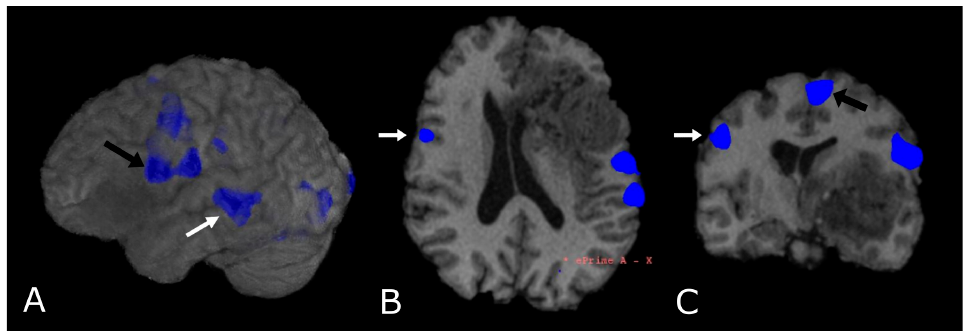
Figure 12. Language task-based fMRI. fMRI correlation maps of cortical activation during language tasks in a patient with frontal-temporal-insular GB. Blue represents areas of increased cortical activation. ( A ) 3D surface rendering with BOLD signal overlay reveals the activation of Broca’s Area, displaced posteriorly by the lesion (black arrow; expressive speech) and in the superior temporal gyrus (white arrow, Wernike’s Area, receptive speech); ( B ) and ( C ) Axial and coronal deskulled T1w-BRAVO with BOLD signal overlay confirm the activation and the dislocation of Broca’s Area and shows a significant but smaller activation in the right inferior frontal gyrus (white arrow’s head). Black arrow’s head indicates the supplementary Motor Area ( C ).